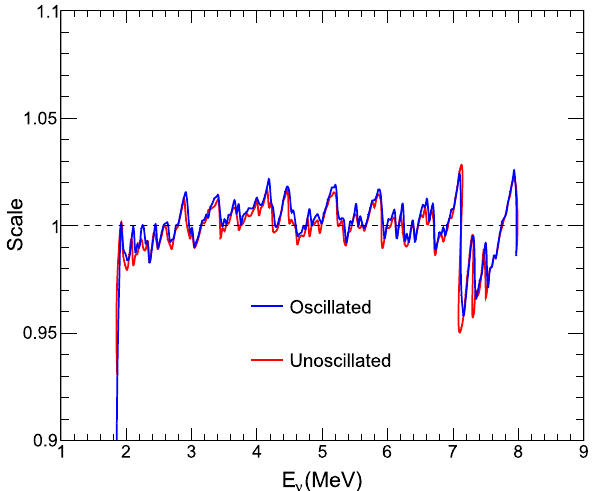
Fig. 10 Estimating the scale of fine structure in two different scenar- ios. Compare the jagged and smooth spectrum (i) without considering oscillation effect (red curve), (ii) with the oscillation effect on the spec- tra taken into account (blue curve). The magnitudes and shapes of these two curves are very similar